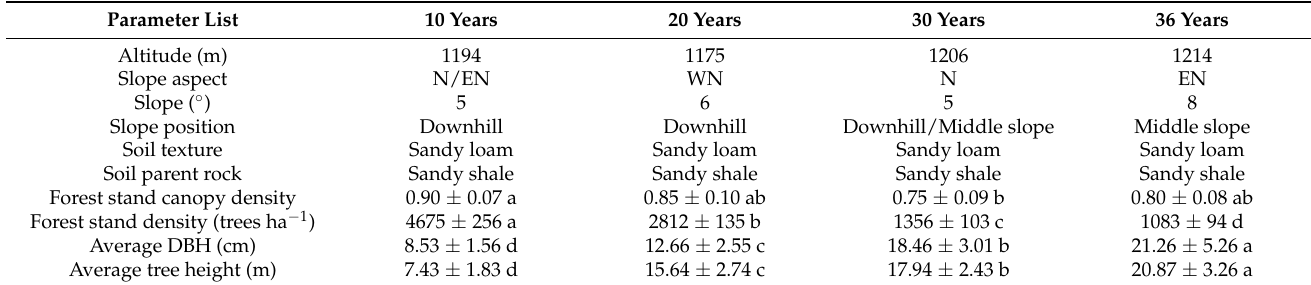
Table 1. The basic situation of different stand ages in Pinus massoniana